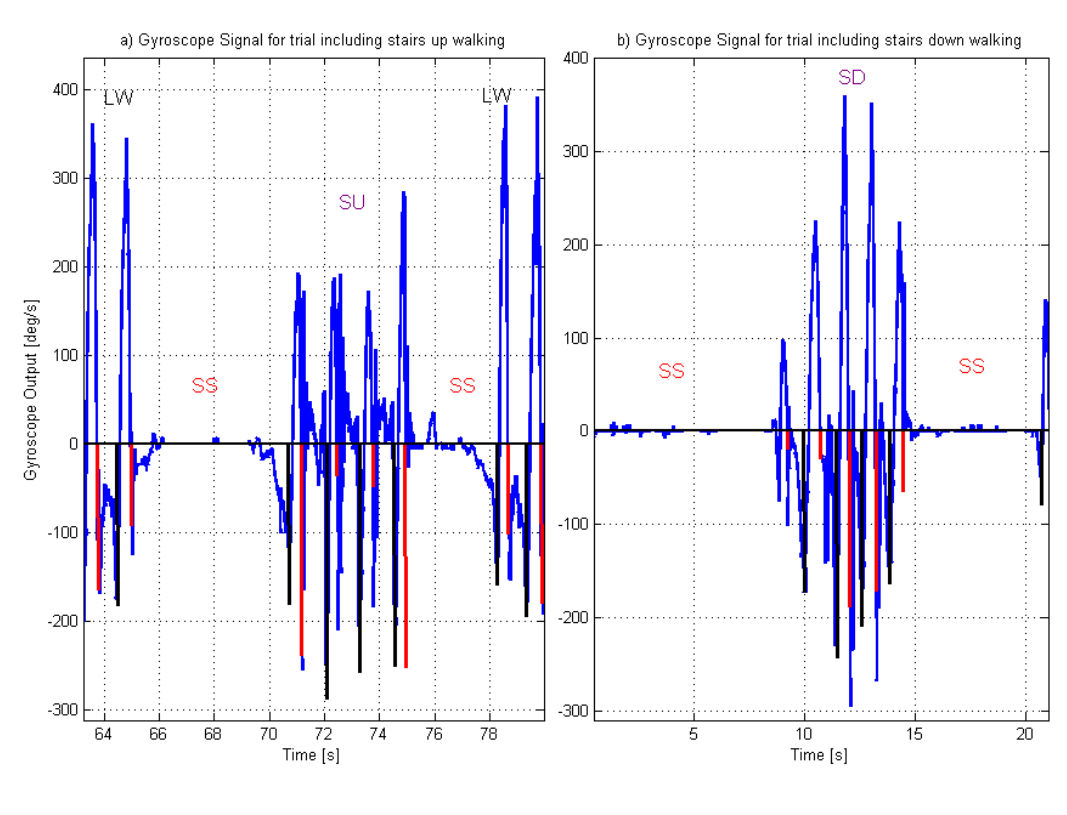
Figure 5. Gyroscope signal for subject 5, for the trial including ascending stairs ( a ) and the one including descending stairs ( b ). Vertical lines indicate the detected events. Subjects walked on level ground walking (LW), then stopped and stood still (SS) before and after walking up (SU) or down (SD) the